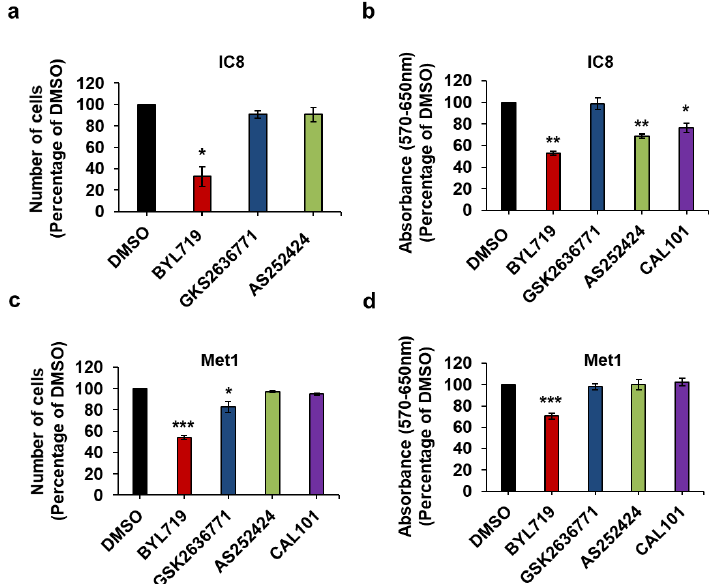
Figure 6. The p110 α inhibitor BYL719 is the most effective in reducing IC8 and Met1 cell numbers and viability. IC8 ( a , b ) and Met1 ( c , d ) cells were treated with 1 µM of the indicated inhibitors or vehicle (DMSO) in complete medium supplemented with 10% FBS. After 72 h, number of cells was assessed by cell counting ( a , c ) and cell viability was assessed by MTT assays ( b , d ). Data are expressed as percentage of results from cells treated with DMSO and are means ± SEM from n = 3 (( a ), apart from AS252424, n = 6), n = 3 ( b ), n = 5 (( c ), apart from GSK2636771, n = 4) and n = 5 ( d ) independent experiments performed in duplicate ( a,c ) or triplicate ( b , d ). * p < 0.05, ** p < 0.01, *** p < 0.001 vs. DMSO. In addition, combination of BYL719 and GSK2636771 did not result in any significant increase in the effect of the p110 α inhibitor on IC8 and Met1 cell numbers (Figure 7a,c) or viability (Figure 7b,d) compared to treatment with BYL719 alone.